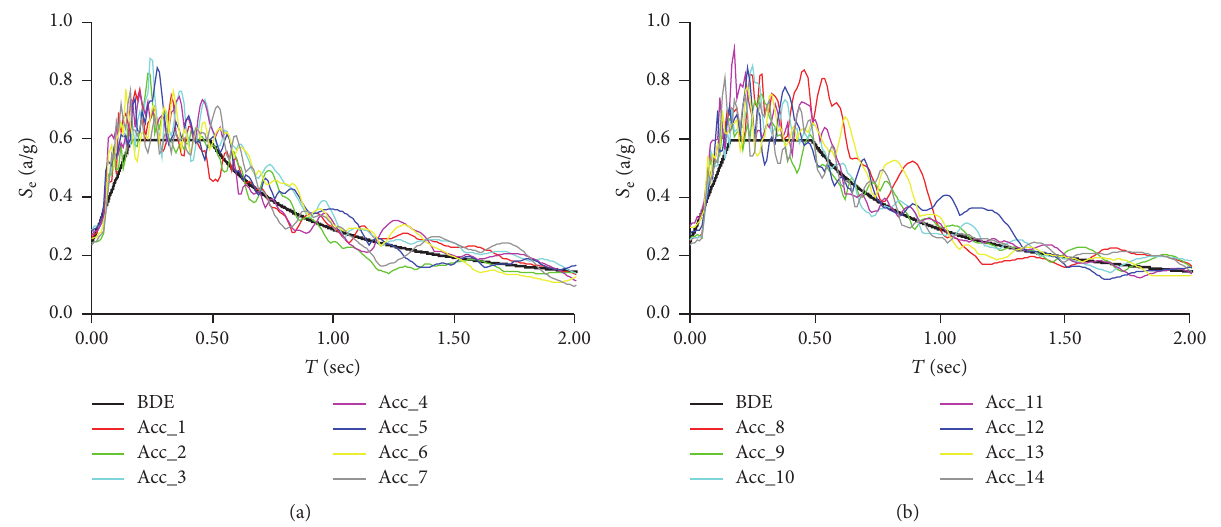
Figure 5: Sets of 7 accelerograms considered for the analysis in (a) direction 𝑋 and (b) direction 𝑌